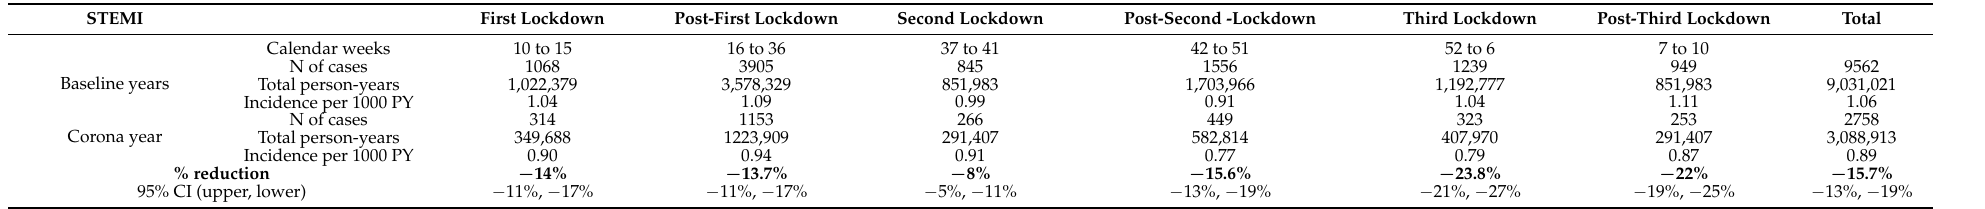
Table 2. STEMI incidence by period for the Corona year and the baseline